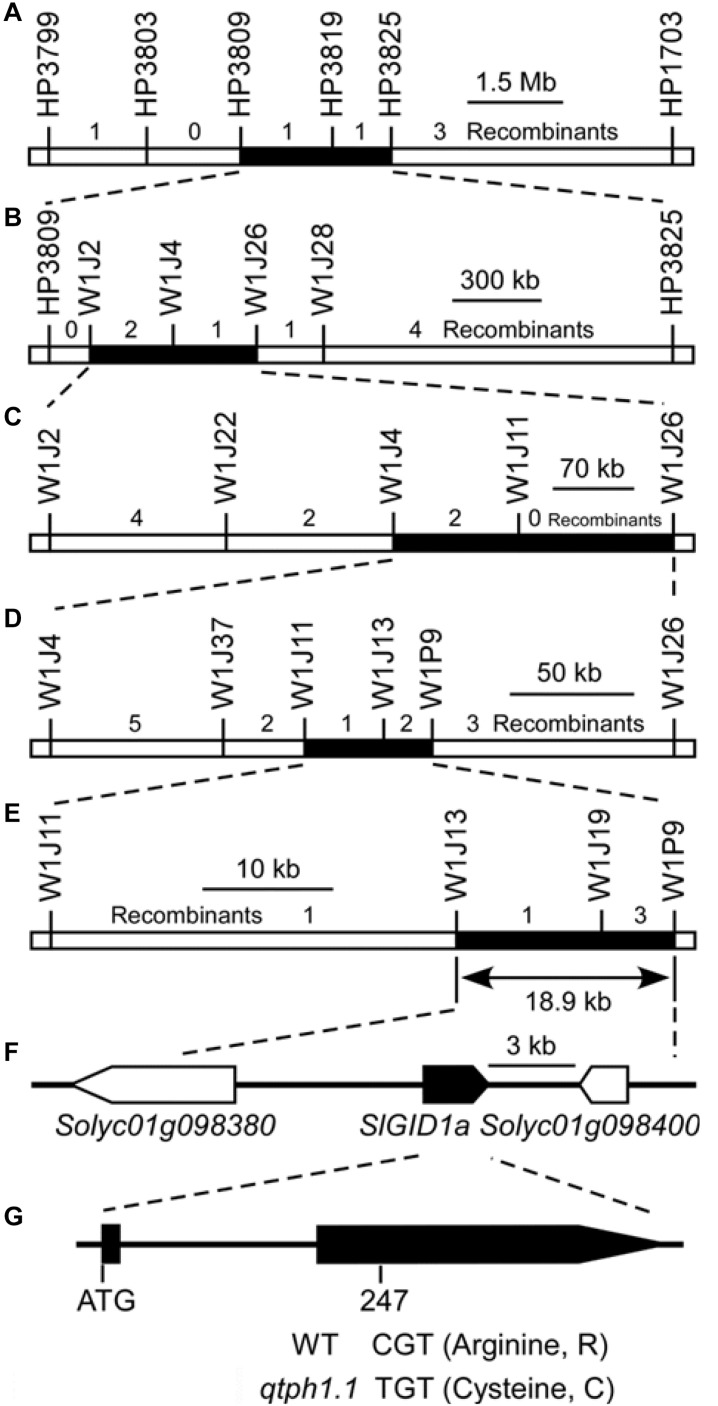
Fine mapping of the qtph1.1 locus. (A–E) The results of five cycles of recombinant progeny tests. (F) The annotated genes of ITAG release 2.40. Arrows indicate the direction of transcription, and the solid arrow presents the putative candidate gene for qTPH1.1. (G) The exon-intron structure of the coding region of SlGID1a and the sequence polymorphism between qtph1.1 (from TS-165) and the wild type (WT, from SG-7). The 247th nucleotide of the coding sequence of SlGID1a was C in SG-7 and T in TS-165, which led to the 83rd amino acid residue in the predicted protein sequence being Arginine (R) in SG-7 and Cysteine (C) in TS-165.